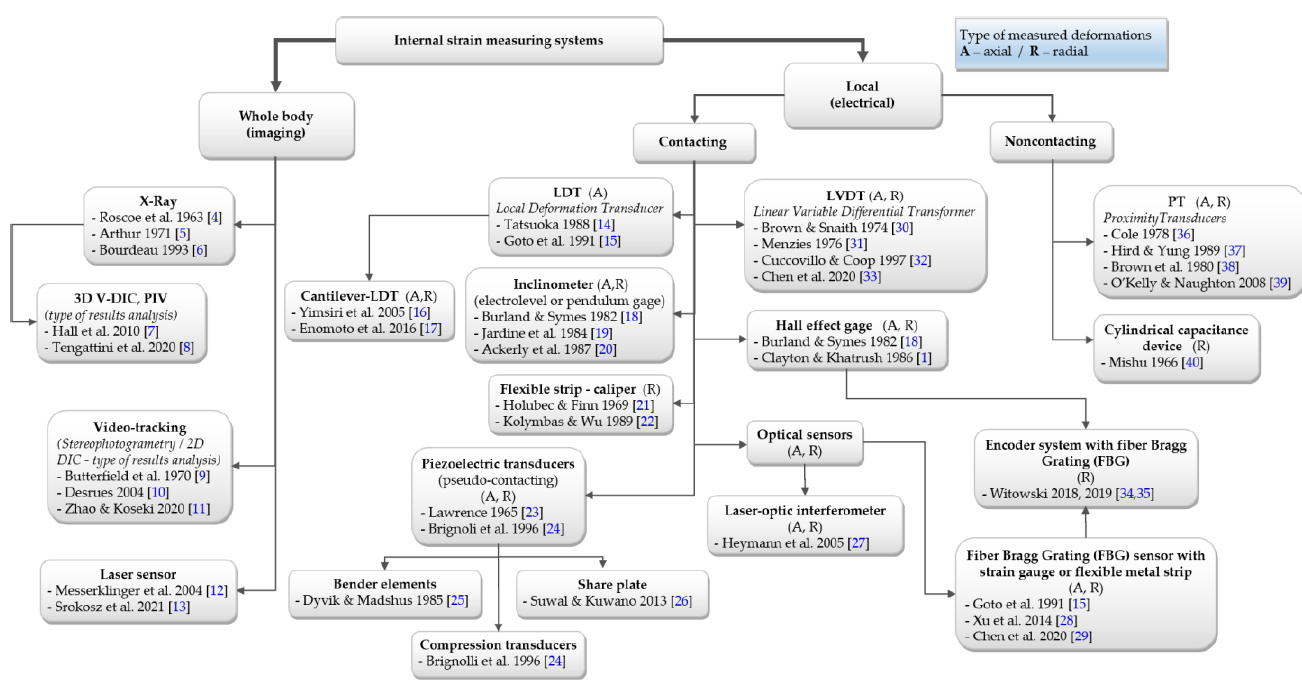
Figure 2. Division of internal deformation measurement systems (based on [3]; with permission via 2021 ASTM International License Number 5071920837322).